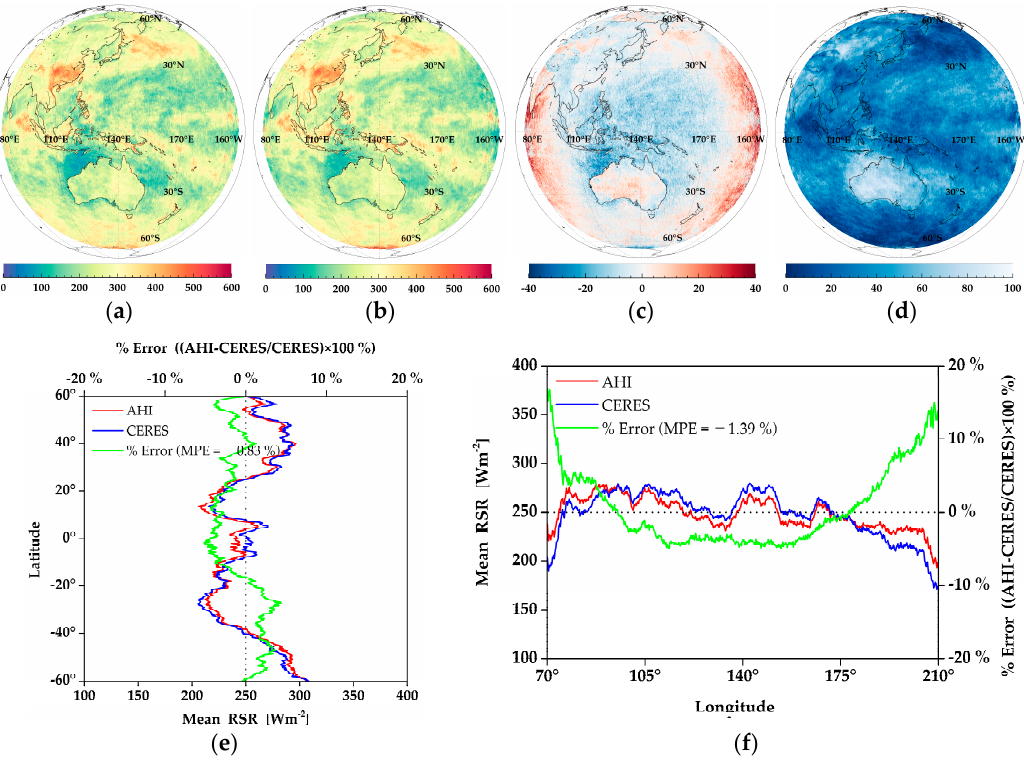
Figure 11. Similar to Figure 10, but for 20 km gridded mean (15 July 2015–15 February 2017) spatial distribution of RSR (Wm − 2 ) from: AHI ( a ); and CERES ( b ); percentage error ( c ); and clear fraction ( d ). Mean RSR from AHI and CERES averaged along each latitude and percentage error on double y axis ( e ); and similar to but along each longitude and percentage error on double x axis ( f ).